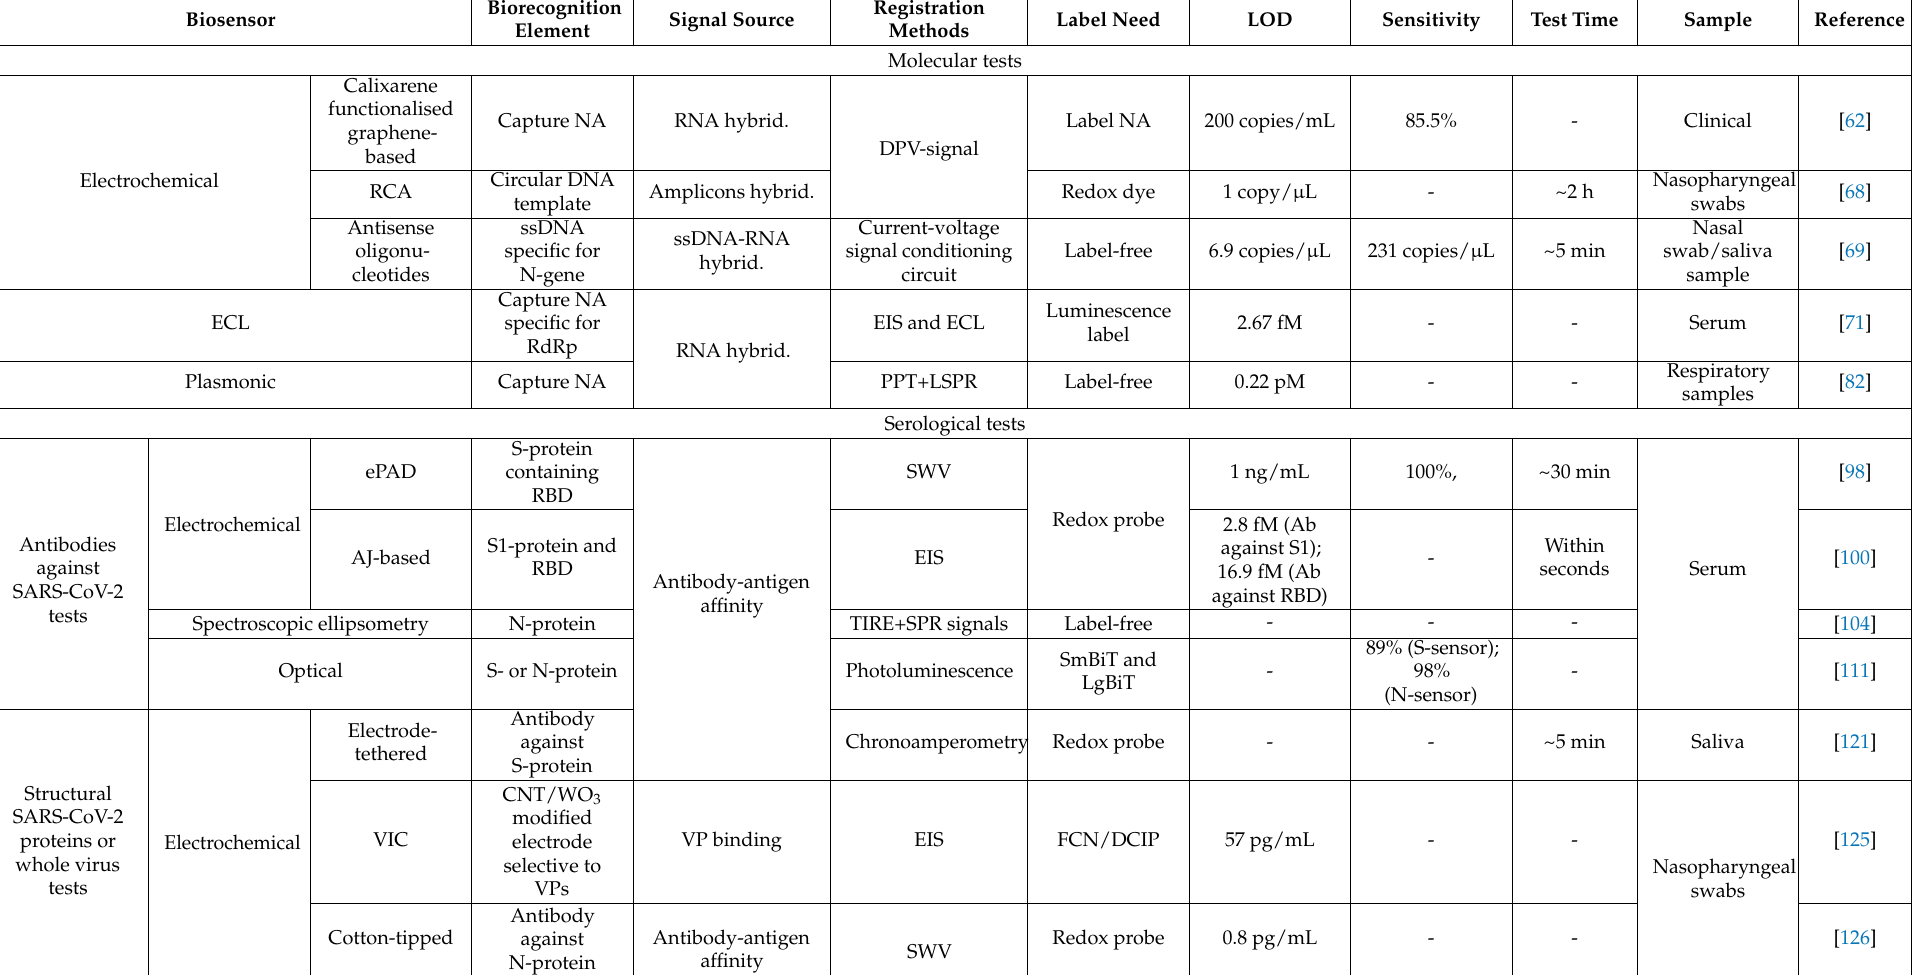
Table 2. Summary table of the reviewed